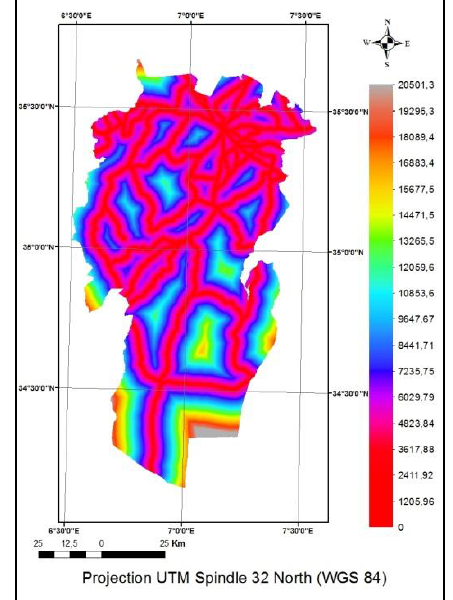
Figure 3: Map of the distances (in meters) from the road